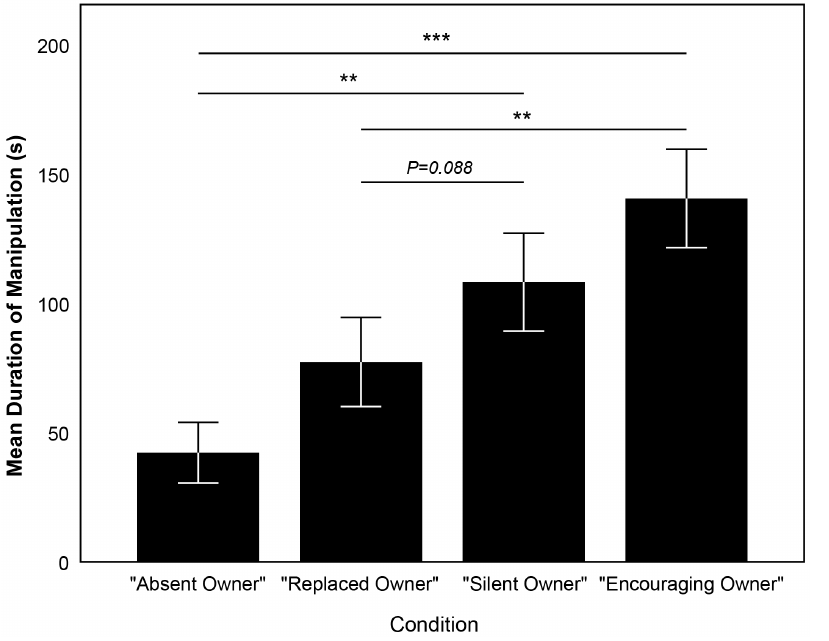
Figure 5. Duration of manipulating the apparatus – Experiment 2. Mean duration of manipulating the apparatus in the conditions ‘‘Absent owner’’ (cAO), ‘‘Replaced owner’’ (cRO), ‘‘Silent owner’’ (cSO), and ‘‘Encouraging owner’’ (cEO). Shown are mean 6 s.e.m. *** represents P # 0.001, ** represents P # 0.01.